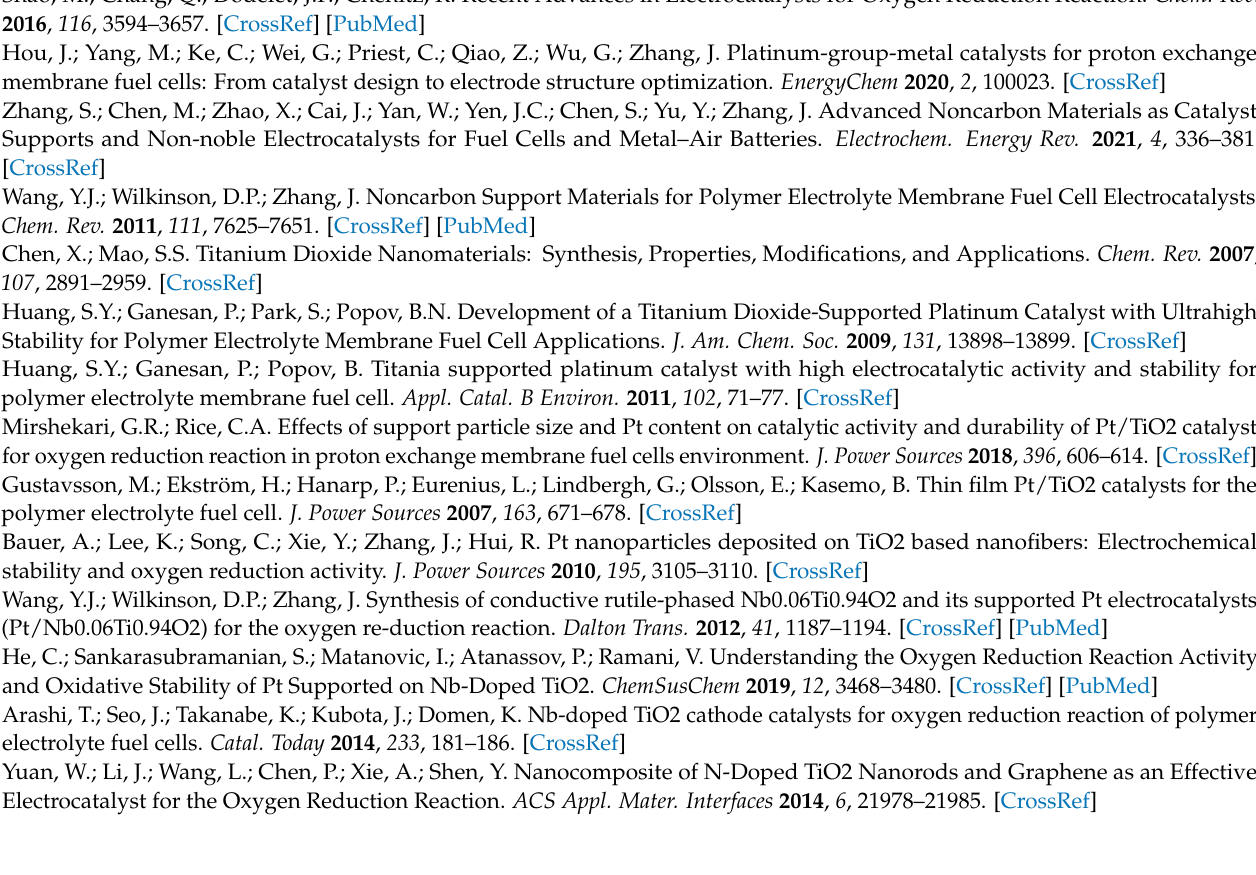
K; Figure S2: XRD patterns of (a) fresh Ti 4 O 7 , and stocked Ti 4 O 7 after (b) 2 months, (c) 4 months; Figure S3: SEM images and corresponding EDX element mapping of Pt, Ti, O of (a–e) Pt/Ti 4 O 7 -5, (f–j) Pt/Ti 4 O 7 -10, and (k-p) Pt/Ti 4 O 7 -20; Figure S4: Cyclic voltammogram curve of JM Pt/C-20 and JM Pt/C-40 in N 2 saturated 0.5 M H 2 SO 4 aqueous solution, scan rate: 50mV/s; Figure S5: TEM images of (a) JM Pt/C-20 and (b) JM Pt/C-40; Figure S6: Schematic diagram of Pt NPs in Pt/Ti 4 O 7 catalysts with different Pt loading; Figure S7: LSV curve of JM Pt/C-20 in O 2 saturated 0.1M KOH aqueous solution, scan rate: 10mV/s; Table S1: ∆ BE of Pt and Ti derived from the respective XPS